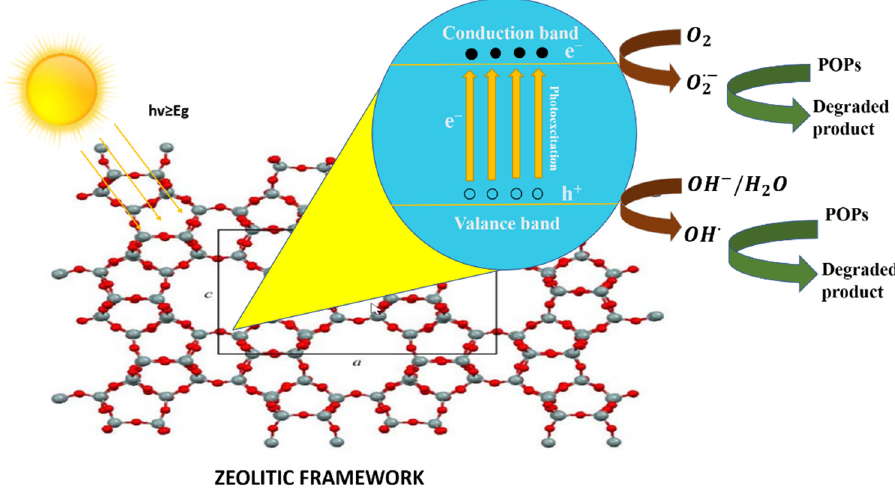
Figure 8. Schematic diagram of photocatalysis in zeolite (image of zeolite framework is reprinted from Ref. [78]).